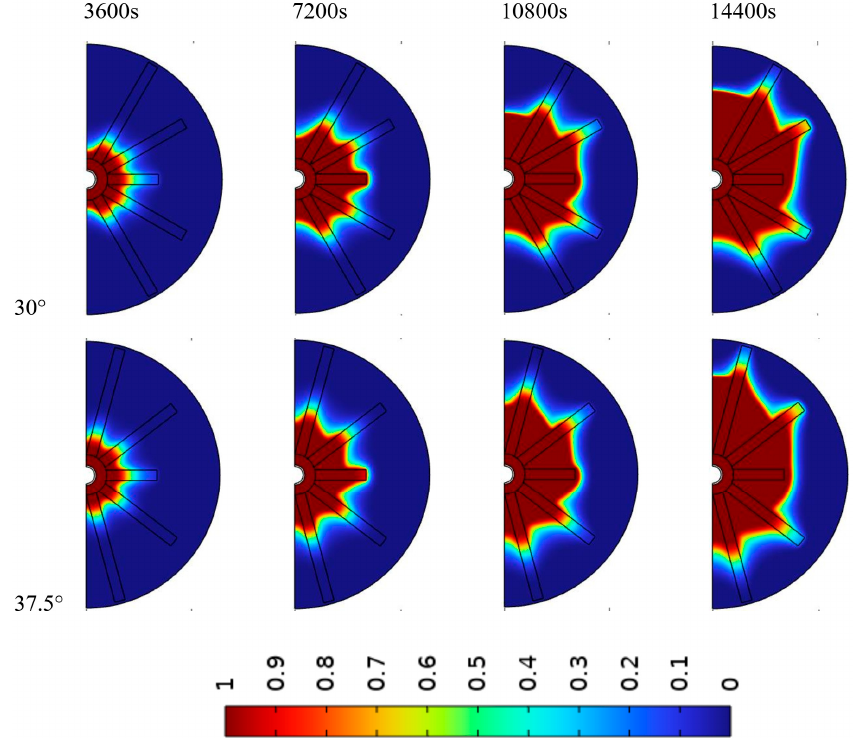
Figure 7. The MVF maps at different time steps for two cases of δ = 30° and δ = 37.5° when ε = 0.95 and ω = 1% wt.